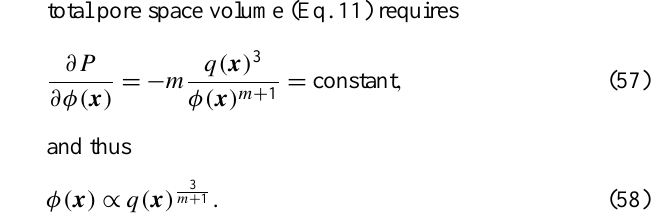
Figure 4. Residence time distributions for the two examples consid- ered in Sects. 4.1 (a) and 4.2 (b) . The nondimensional time axis is scaled in such a way that the mean residence time is one for the ho- mogeneous distribution of the conductivity, and the total pore space volume is the same in all